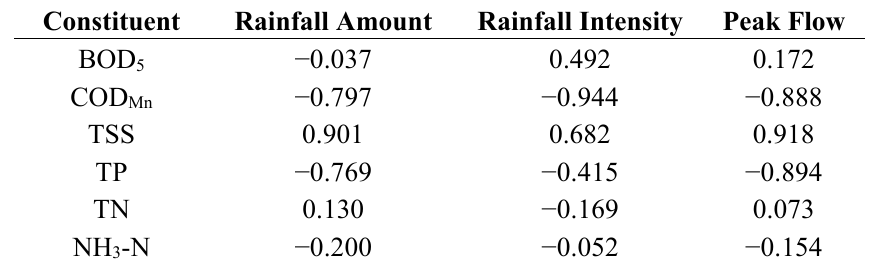
Table 3. Correlation analysis between EMCs and rainfall runoff characteristics.